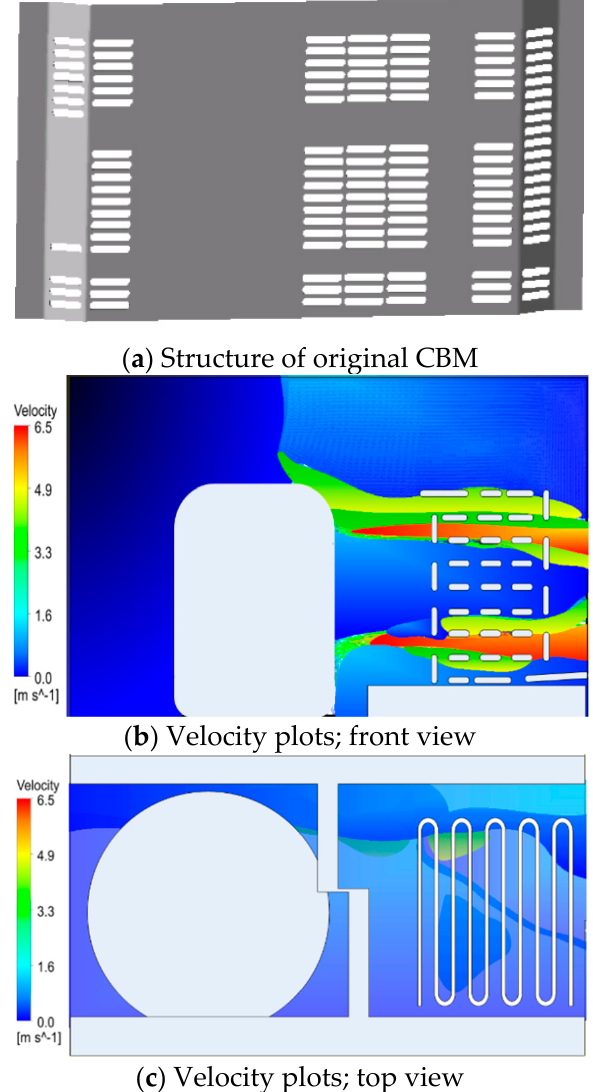
Figure 13. Original cover back machine (CBM) and flow pattern in the machine room of the refrigerator.